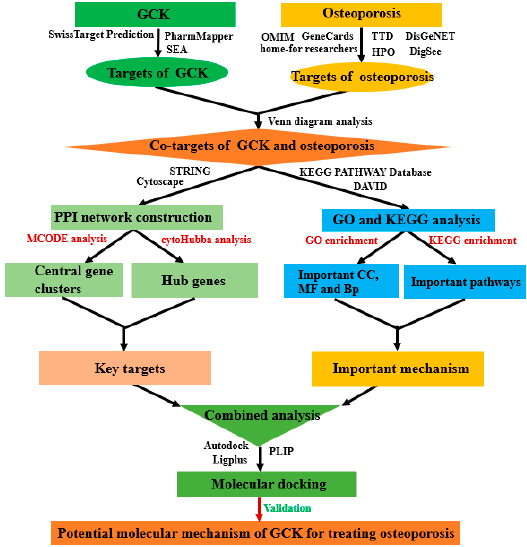
Figure 1. Workflow diagram of network pharmacology analysis of targets and molecular mechanism of GCK for treating